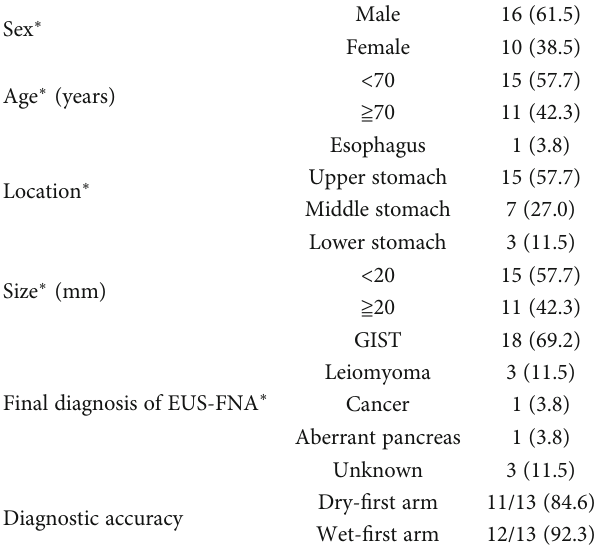
Table 3: Specimen cellularity of each technique in each